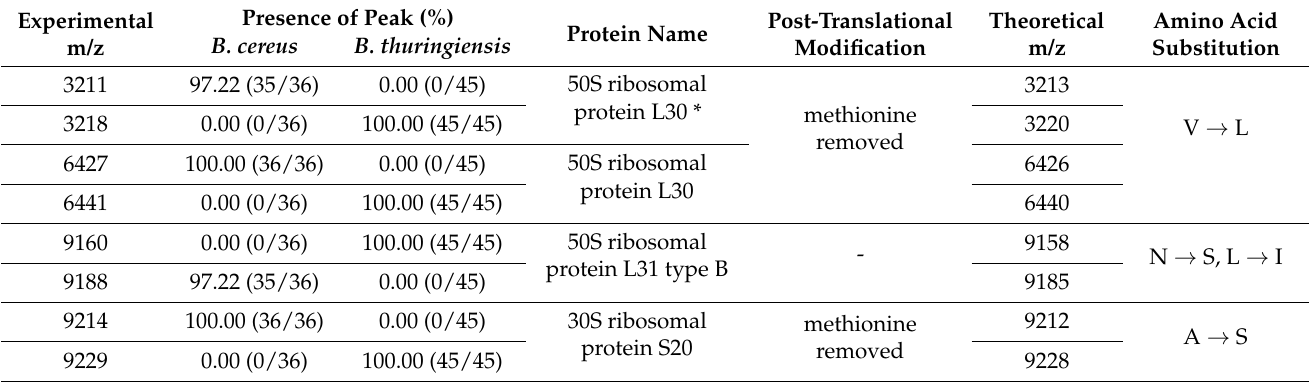
Figure 2. MALDI-TOF mass spectra and species-specific peaks of Bacillus cereus (orange) and Bacillus thuringiensis (green). The y -axis indicates peak intensities, and the x -axis indicates the m/z values; ( A – C ) represent enlarged views of species-specific peaks. Table 2. Frequencies and assignments of species-specific peaks for Bacillus cereus and Bacillus thuringiensis .